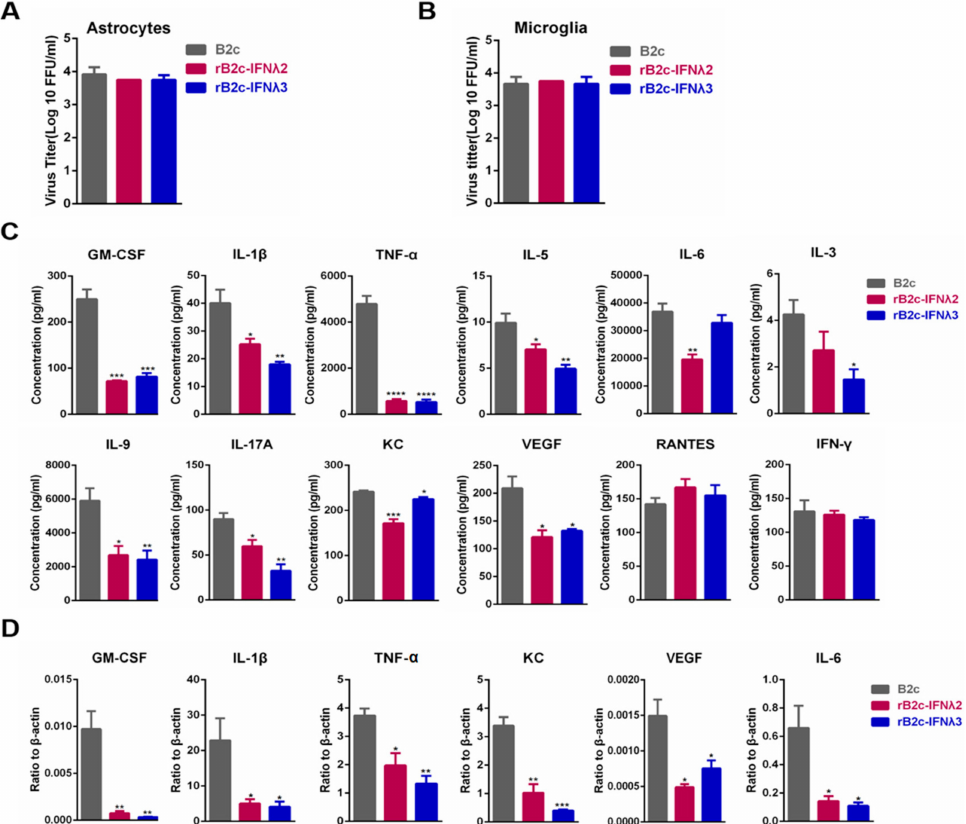
Figure 6. IFN- λ reduces the production of inflammatory cytokines in primary astrocytes and microglia cells. Astrocytes and microglia cells isolated from 2-day-old suckling mice were infected with B2c, rB2c-IFN λ 2, or rB2c-IFN λ 3 at a MOI of 5, and cell supernatants and lysates were collected at 48 hpi for astrocytes and microglia cells, respectively, for the determination of indicated cytokines. The rRABV titers were measured using a focus-forming assay and are expressed as FFU / mL on astrocytes ( A ) and microglia cells ( B ). Concentrations of the indicated cytokines in astrocyte supernatants were measured using a cytokine array ( C ) and microglia cells lysates were measured by qRT-PCR ( D ). Error bars represent the SE ( n = 3). The following notations were used to indicate significant di ff erences between groups: *, p < 0.05; **, p < 0.01; ***, p < 0.001; ****, p <